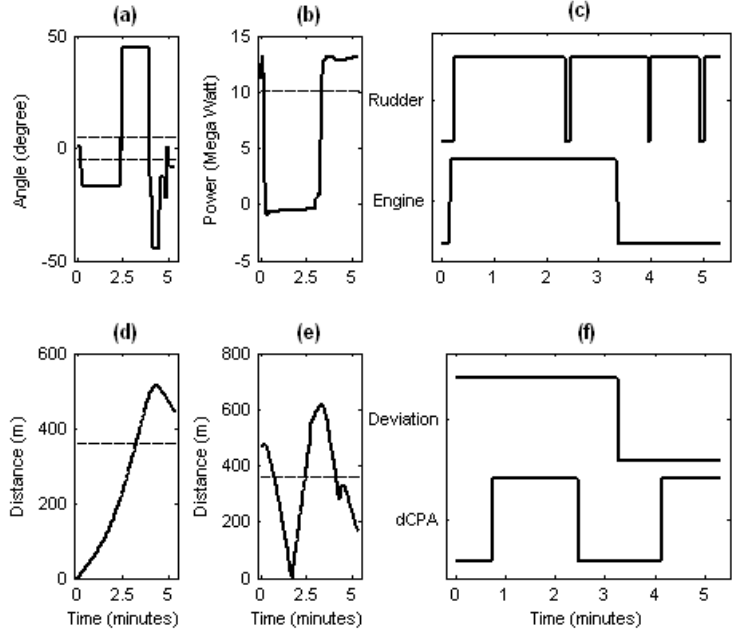
Figure 7. Examples of behavior feature detection of a participant who failed to avoid a collision: (a) rudder angle; (b) engine power; (c) feature detection results for (a) and (b); (d) controlled deviation; (e) controlled dCPA; and (f) feature detection results for (d) and (e).